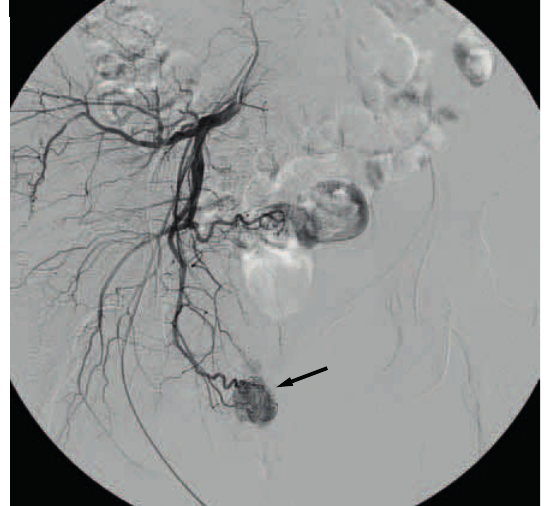
Figure 3. The arrow points at a hypervascularised mass shown by the arteriography previous to the embolization of a lower right haemorrhoidal branch of the hypogastric artery.